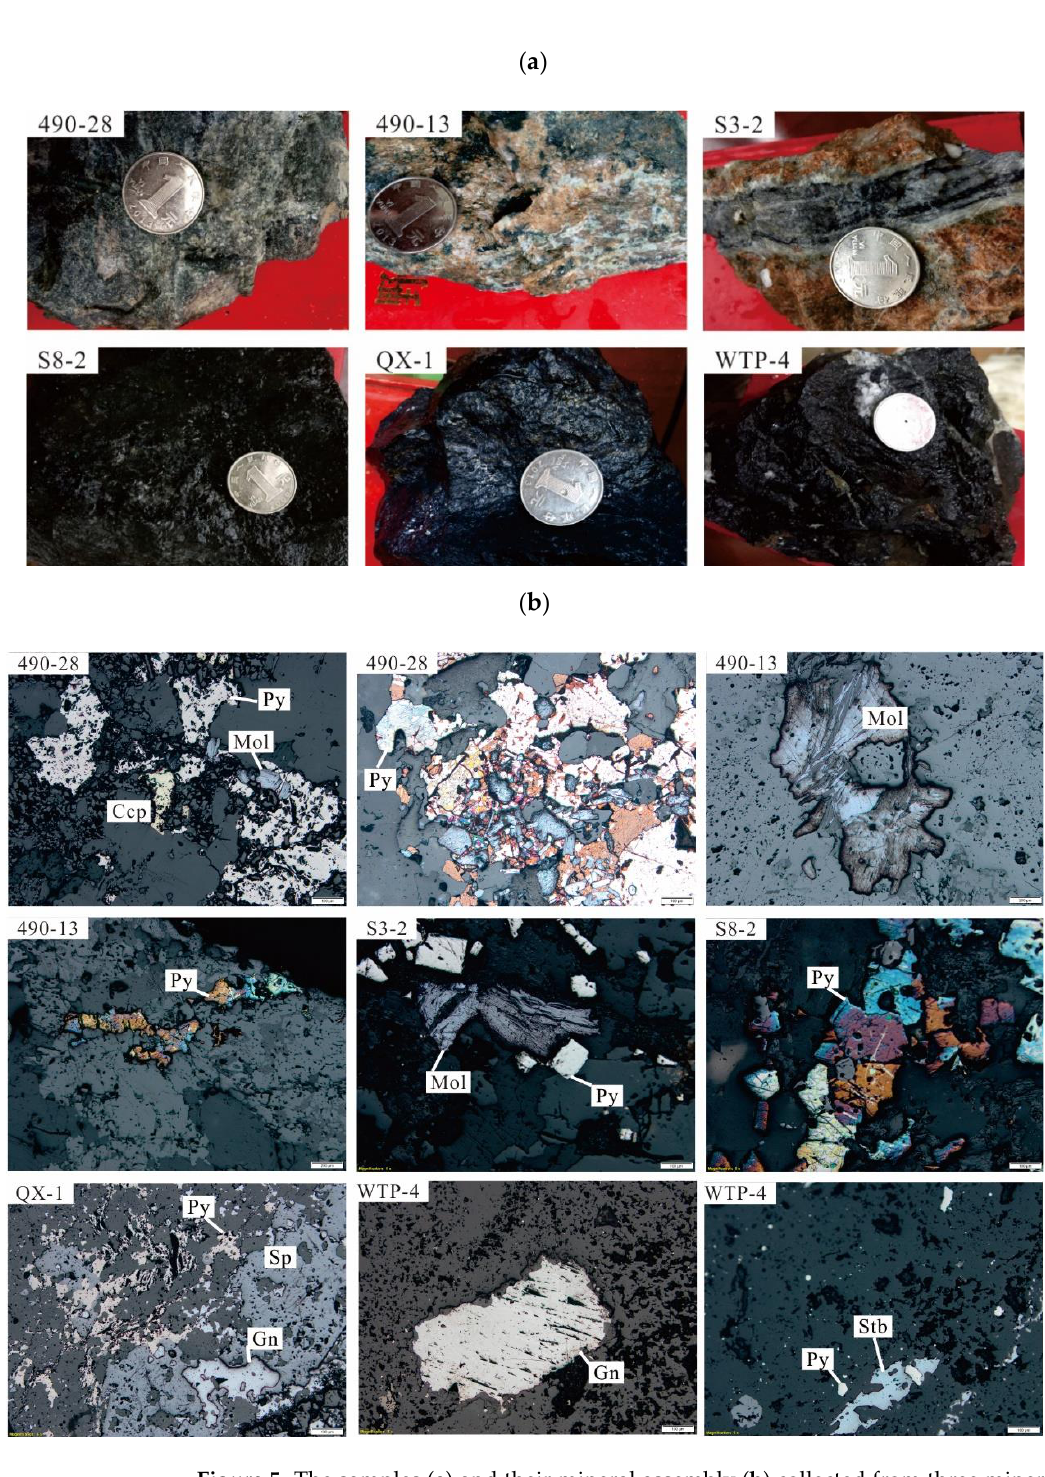
Figure 5. The samples ( a ) and their mineral assembly ( b ) collected from three mineralizing zones. W-Sn-Mo-Bi zone: 490-28, 490-13 and S3-2; Pb-Zn: S8-2; and QX-1; Hg-Sb: WTP-4. Abbreviations: Py: pyrite; Mol: molybdenite; Ccp: chalcopyrite; Sp: sphalerite; Gn: galena; Stb: stilbite.